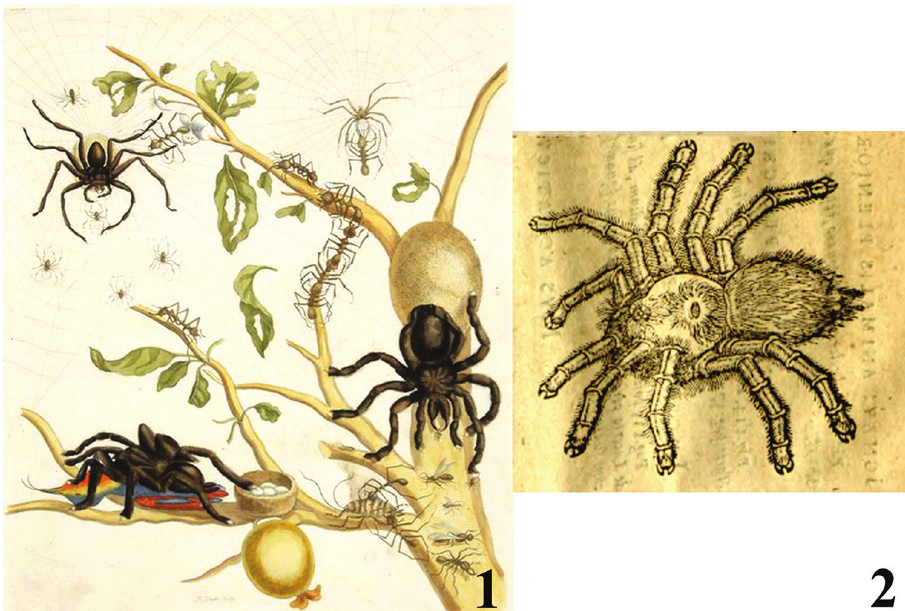
Figures 1–2. Historical aviculariine drawings. 1 Maria Sybilla Merian’s plate from Metamorphosis insec- torum Surinamensium (1705) depicting an Avicularia avicularia eating a bird 2 Clusius’ (1611) drawing of a possible Pachistopelma sp., the oldest known illustration of a tarantula (Theraphosidae, Aviculariinae) in the New